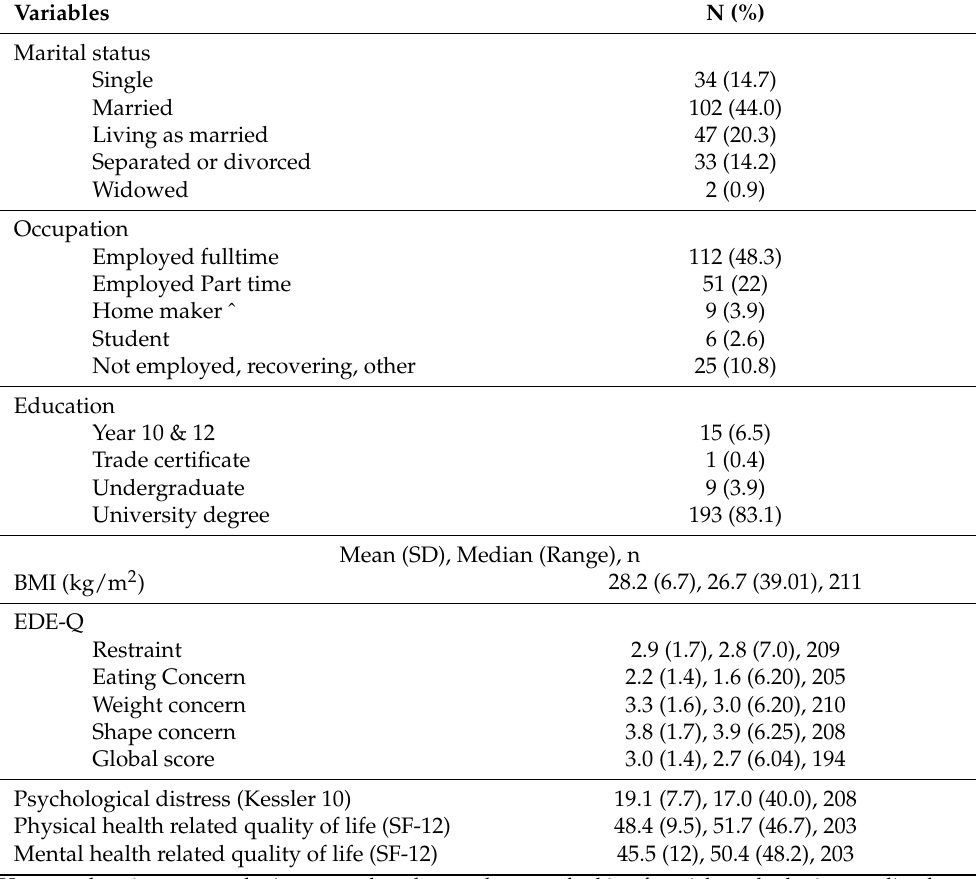
Table 1. Participant’s demographic and health related features (n = 232).